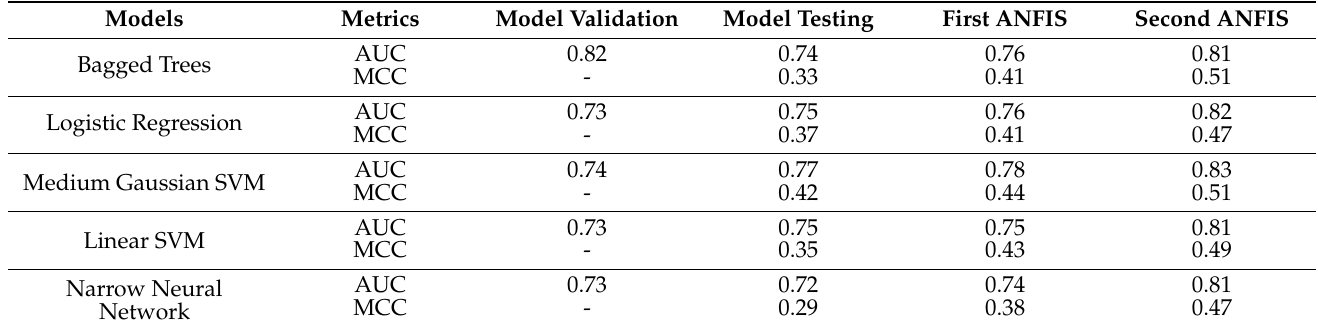
Table 12. Test results for AHI 25.